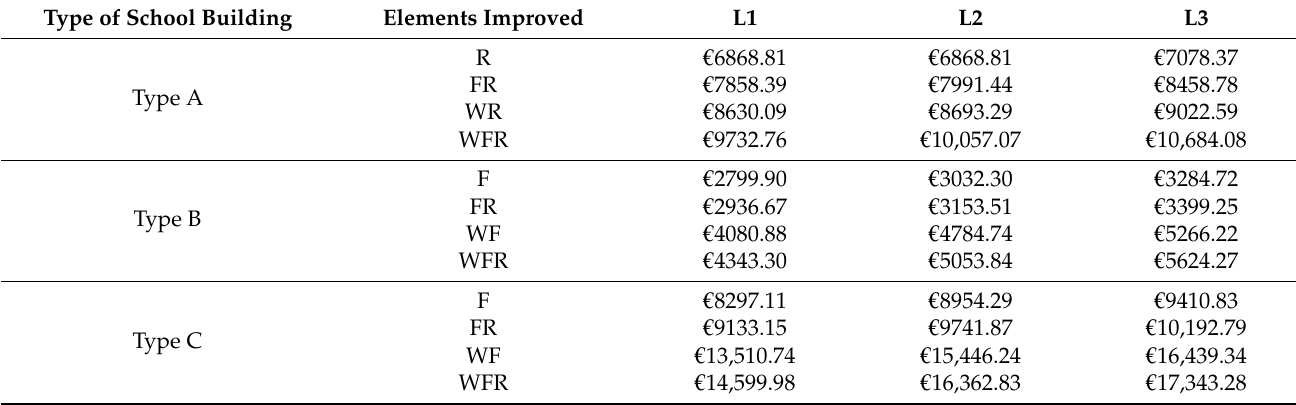
Table 7. Average annual saving according to type of school building due to reduction in energy consumption, according to sets of measures.